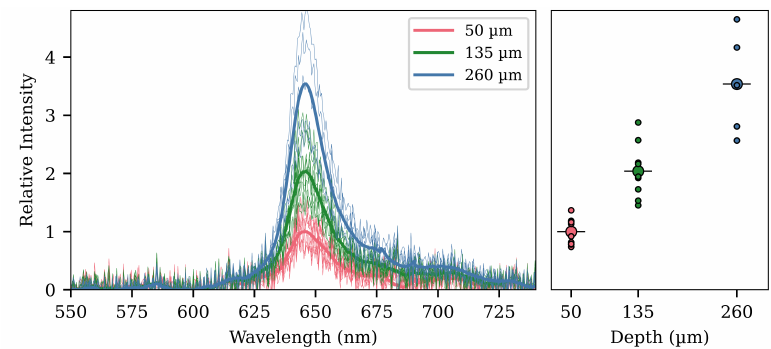
Figure 5. Photoluminescence spectra and signal response from the cavity-depth experiments.